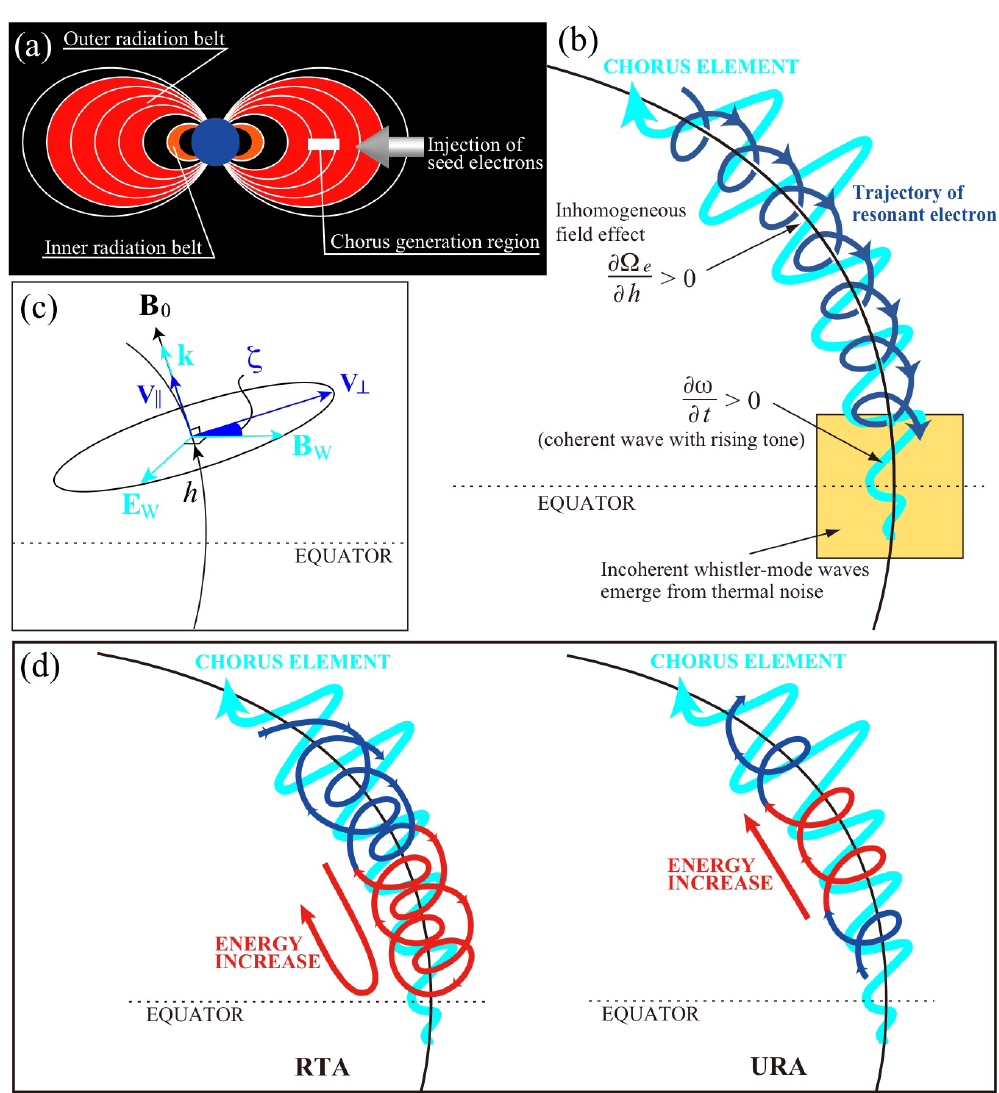
Fig. 1. (a) Earth’s radiation belts; (b) Chorus wave generation near the equator; (c) Vector geometry of a whistler-mode wave in a dipole mag- netic field, and velocity components of a resonant electron; (d) The relativistic turning acceleration (RTA) and ultra-relativistic acceleration (URA) mechanisms operating near the